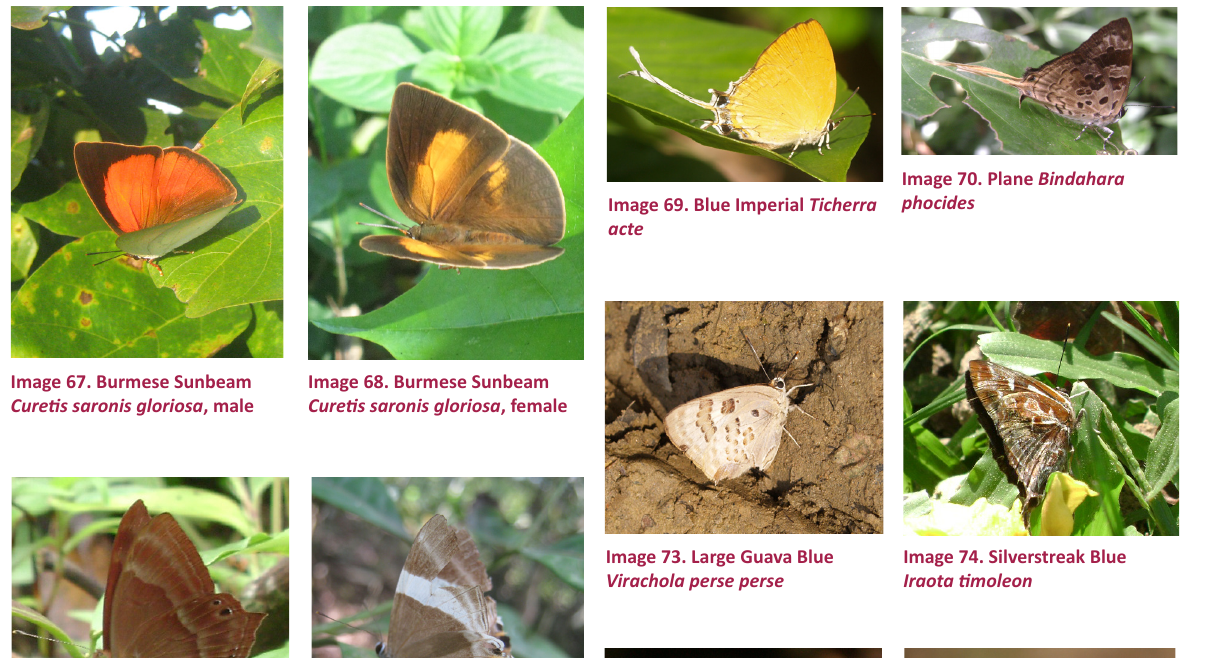
Image 74. Silverstreak Blue Iraota timoleon